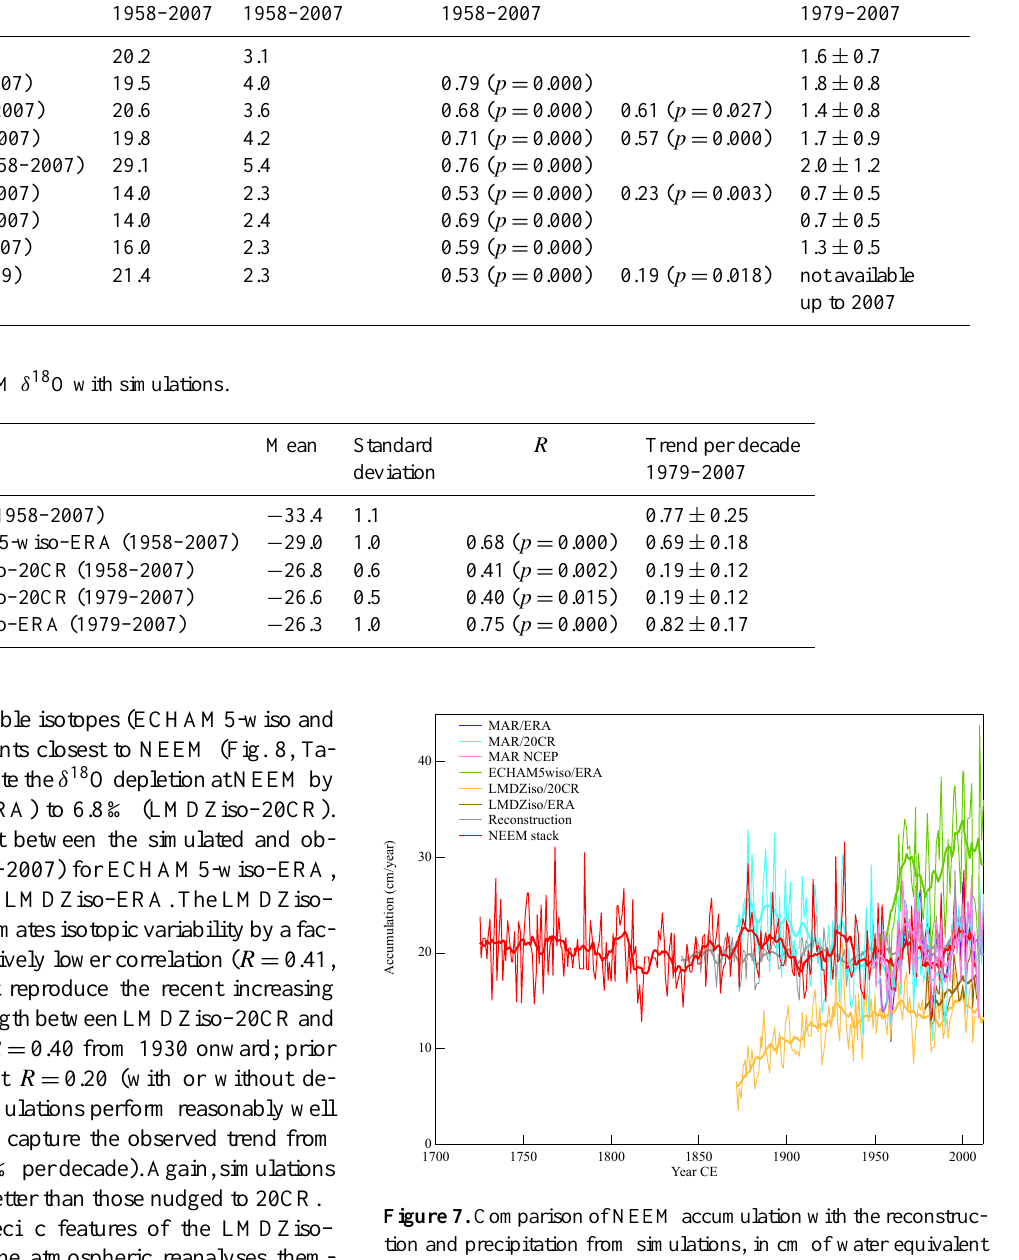
Table 2. Comparison of NEEM accumulation (cm water equivalent per year) with gridded data from the reconstruction (Box et al., 2012) and from simulations. The mean values and standard deviations are reported for 1958–2007. Accumulation Mean Standard deviation R R before 1958 Trend per decade (cmw.e.yr − 1 )